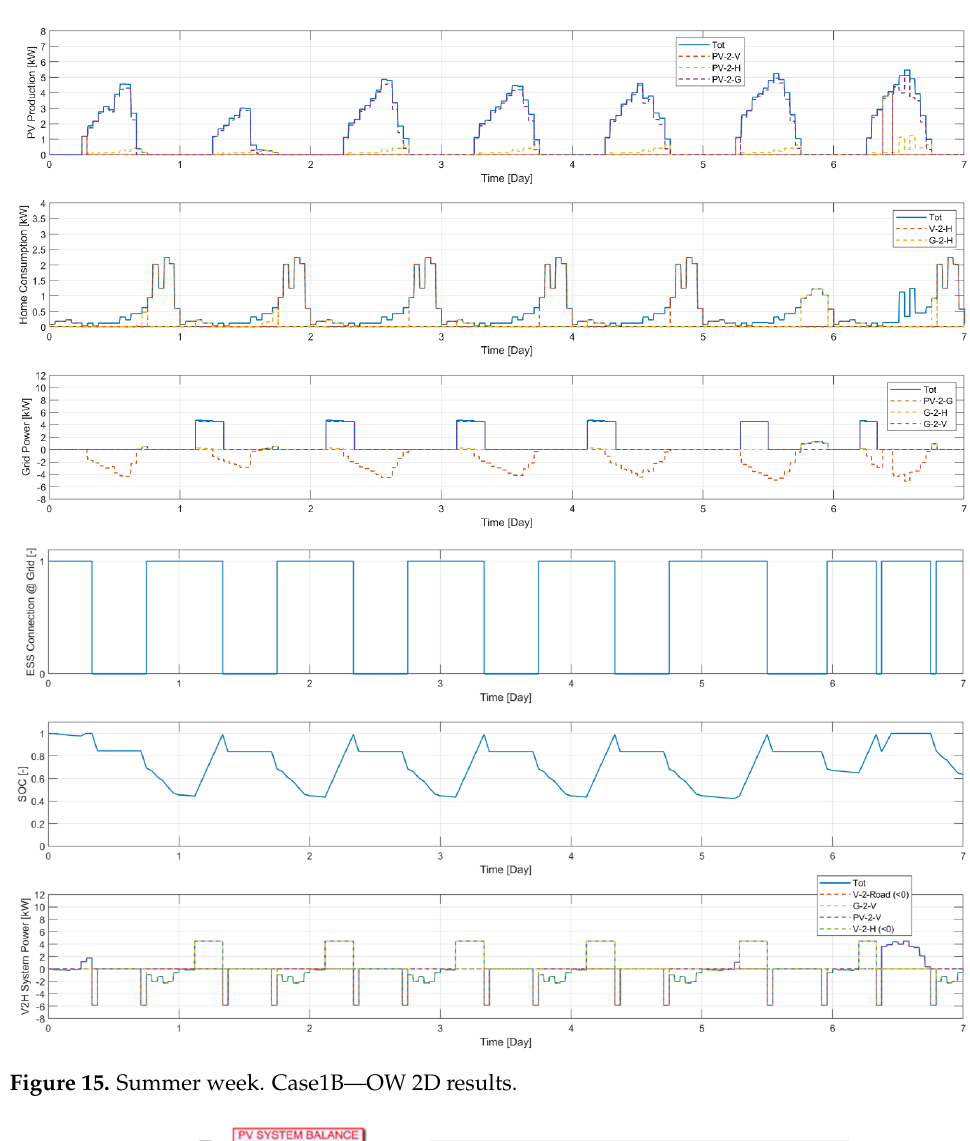
Figure 15. Summer week. Case1B — OW 2D results.